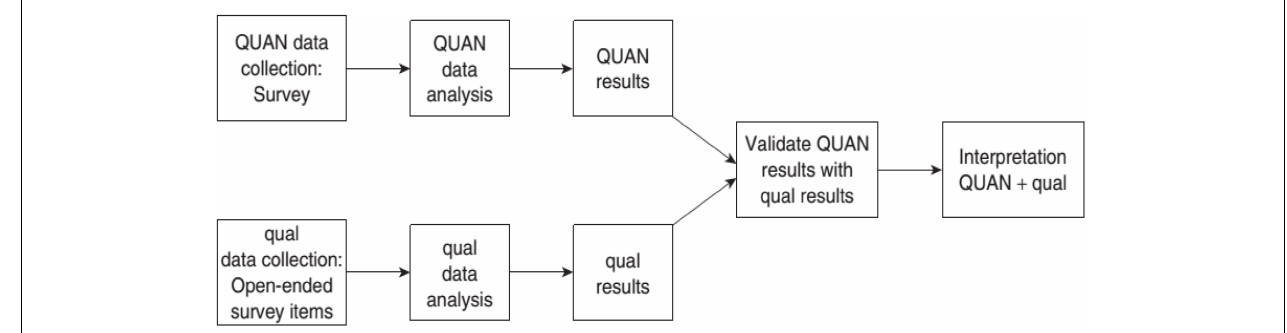
FIGURE 1 | Triangulation design: validating quantitative data model [from Creswell and Plano Clark (2006)].